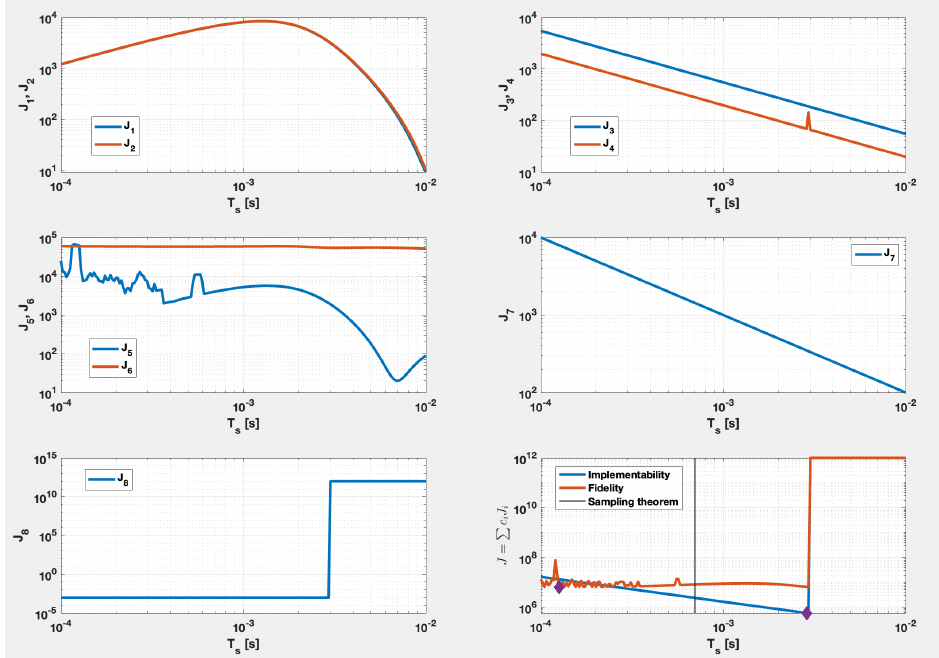
Figure 7. Functionals J 1 − J 8 , corresponding to (cid:83) Ω and their weighted sum as in Equation (23) for both performed experiments. Besides the imple- mentability and fidelity cases, a classical sampling-theorem approach is